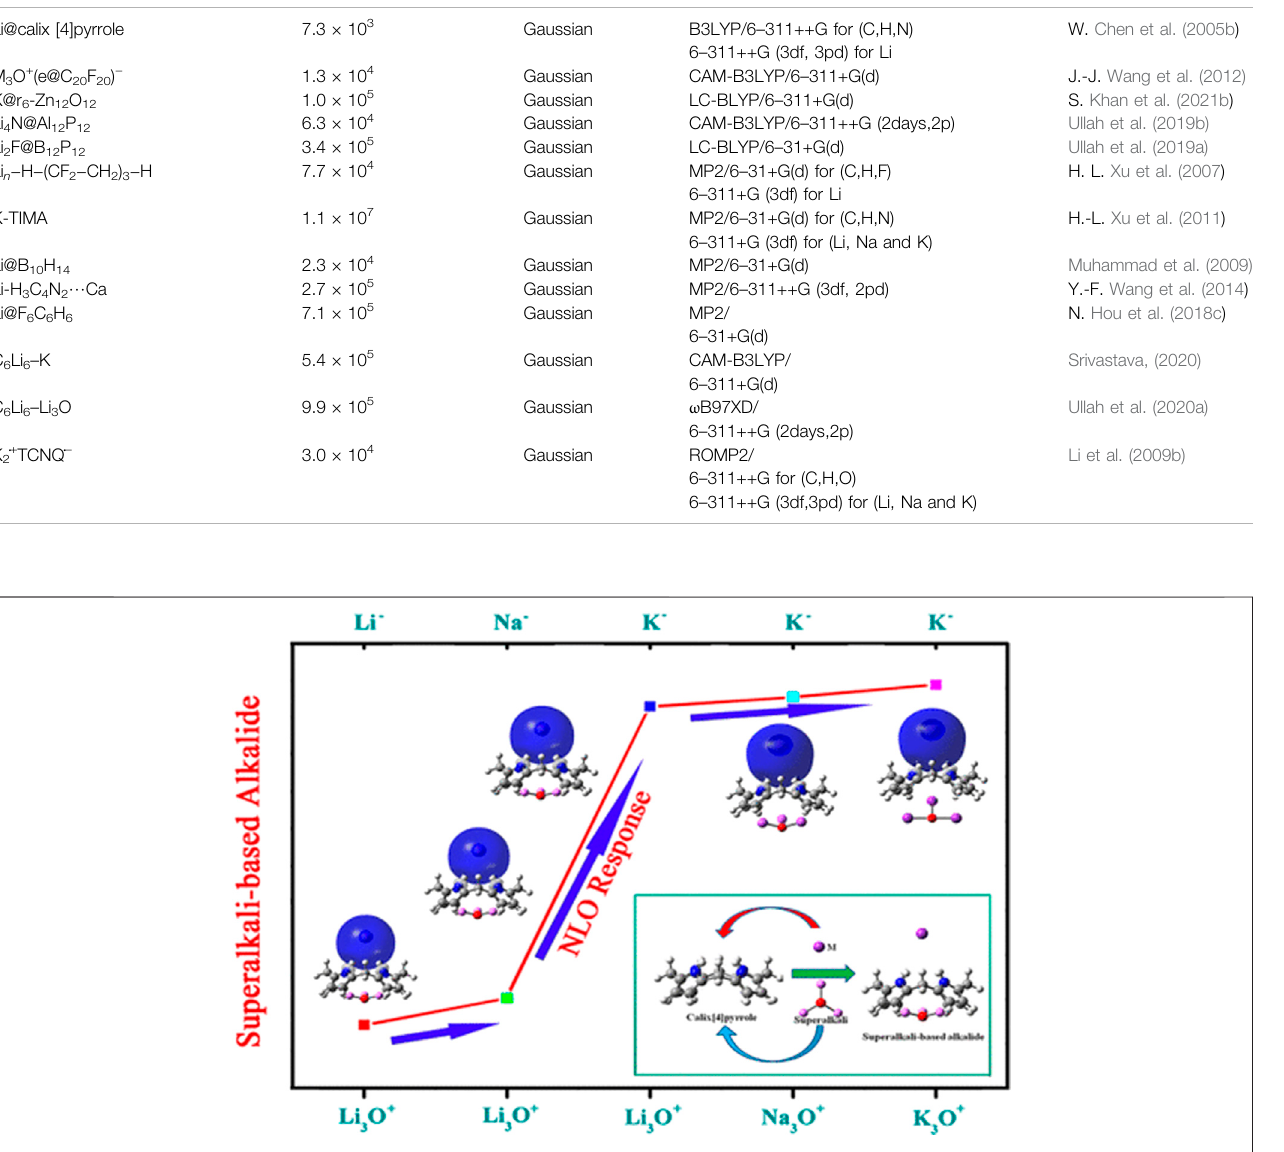
TABLE 1 | Some excess electron based electride complexes with enhanced NLO response. Complex